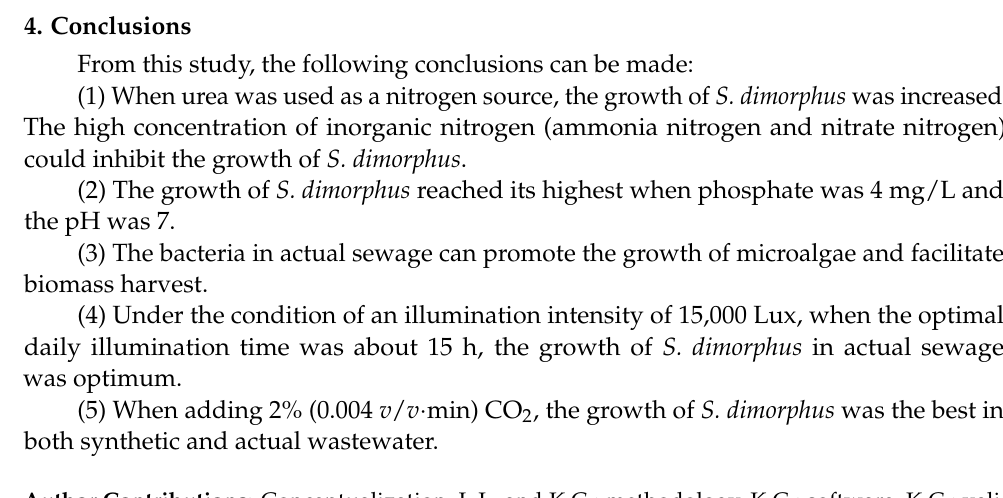
Figure 7. Growth curve of Scenedesmus dimorphus under different CO 2 concentrations in ( a ) synthetic wastewater and ( b ) actual wastewater ( n = 3).